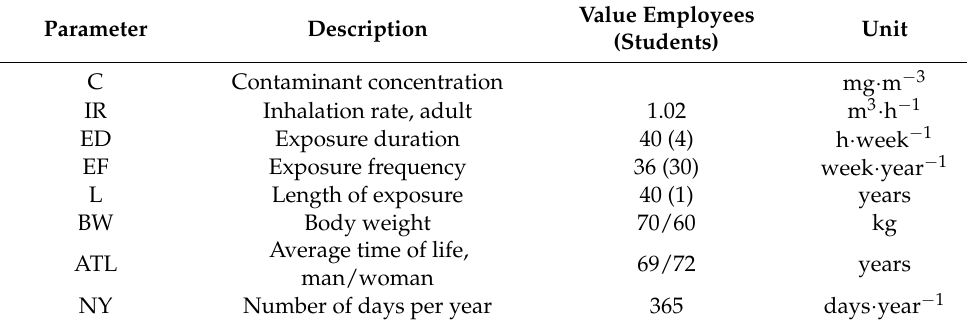
Table 1. The data for the calculation of cancer risk of employees and